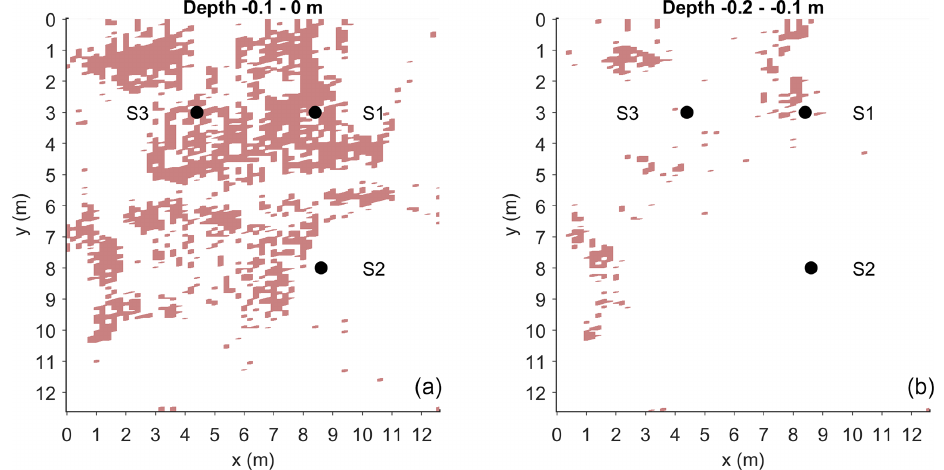
Figure 12. Imaging results in terms of the imaginary component of the complex conductivity σ (cid:48)(cid:48) > 100µSm − 1 and phase φ > 18mrad, indicating the hotspot geometry at depths of (a) 10cm and (b) 20cm. The dots represent the locations of the vertical sampling profiles S1, S2, and